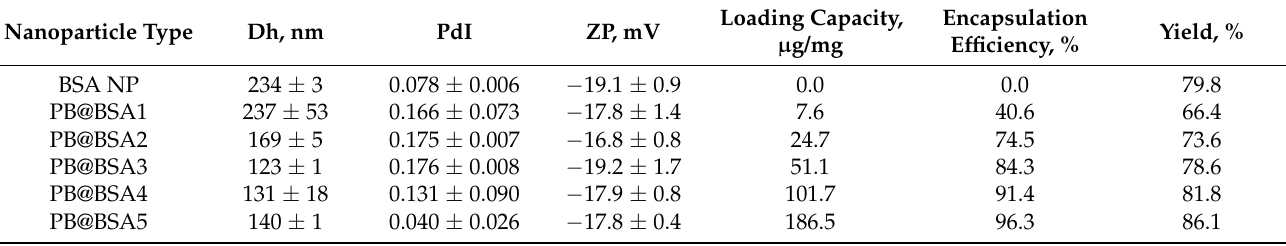
Figure 1. ( A ) Scheme of nanoparticle synthesis; ( B – D ) different stages of PB@BSA1 synthesis: a mix- ture of BSA and nanozymes before ( B ) and after the addition of 1 ( C ) or 4 ( D ) mL of ethanol; ( E )